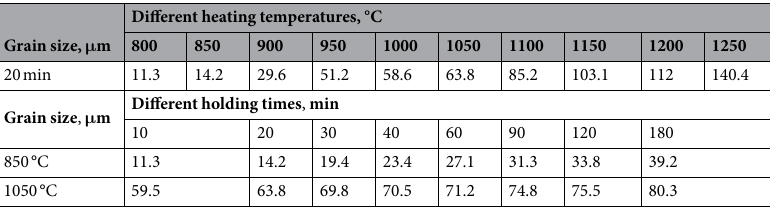
Table 1. The statistics of d under different heating temperatures and different holding